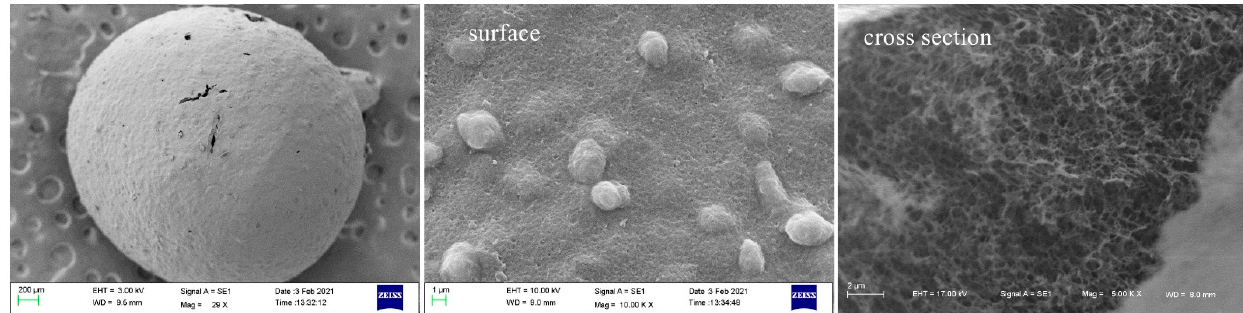
Figure 3. SEM images of the whole, surface, and cross-section of porous chitosan/saccharomycetes microspheres prepared with the mass ratio of chitosan to saccharomycetes and silica gel of